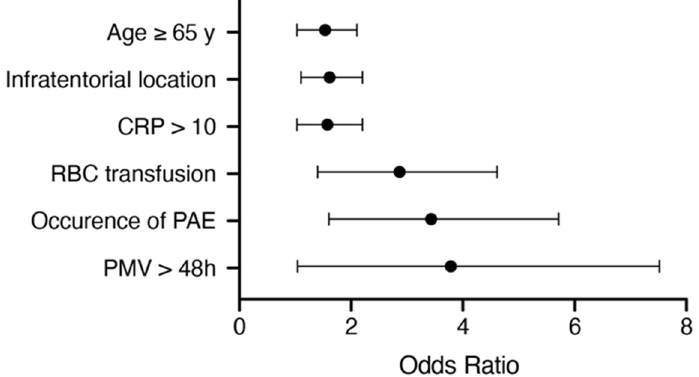
Figure 4. Results from the multivariate analysis. CRP: C-reactive protein; PAE: perioperative adverse events; PMV: prolonged mechanical ventilation; RBC: red blood cells.